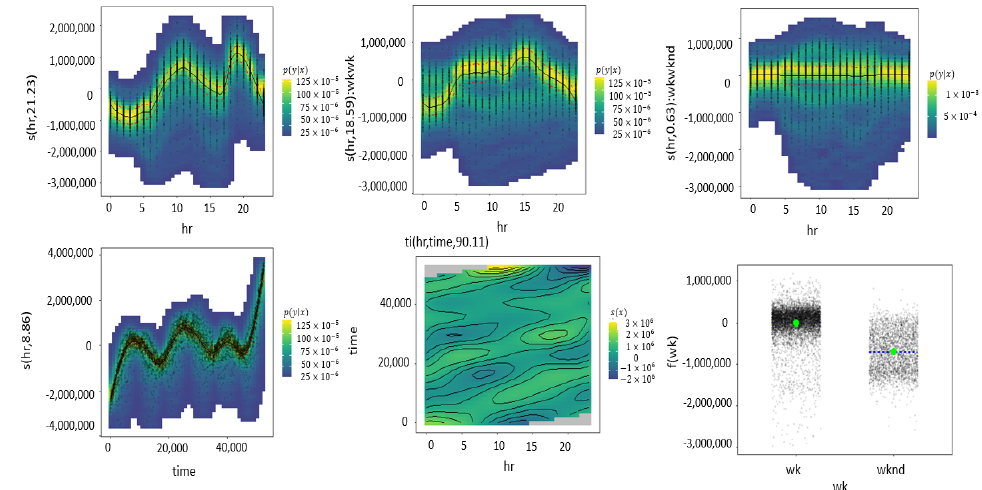
Figure 7. Partial effects for the non-spatial GAM: effects for individual covariates, interaction covariates, and parametric factor